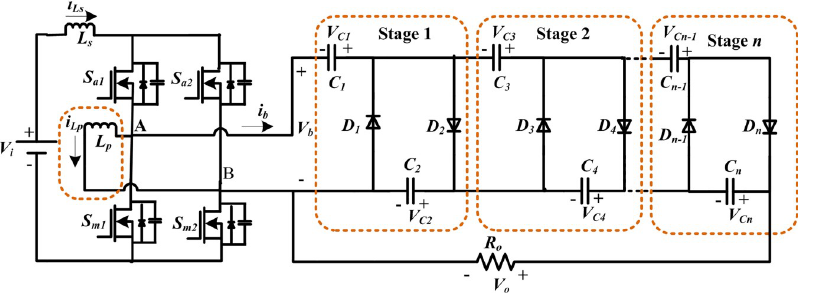
Fig 1. Proposed FB cascaded CW multiplier based dc-dc